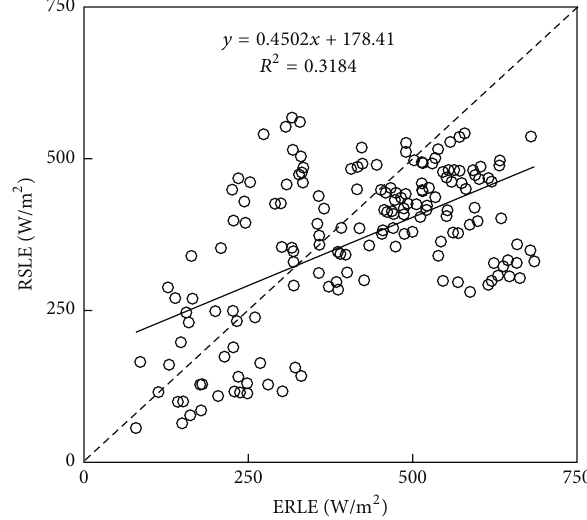
Figure 4: Overall comparison between ERLE and